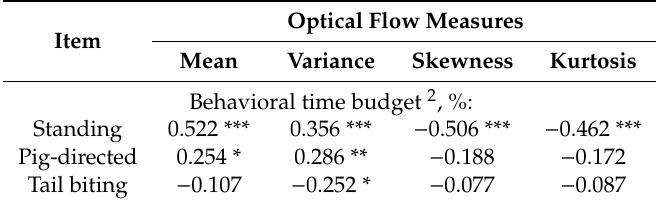
growing-finishing pigs in 4 pens that experienced tail-biting outbreaks during the study period 1